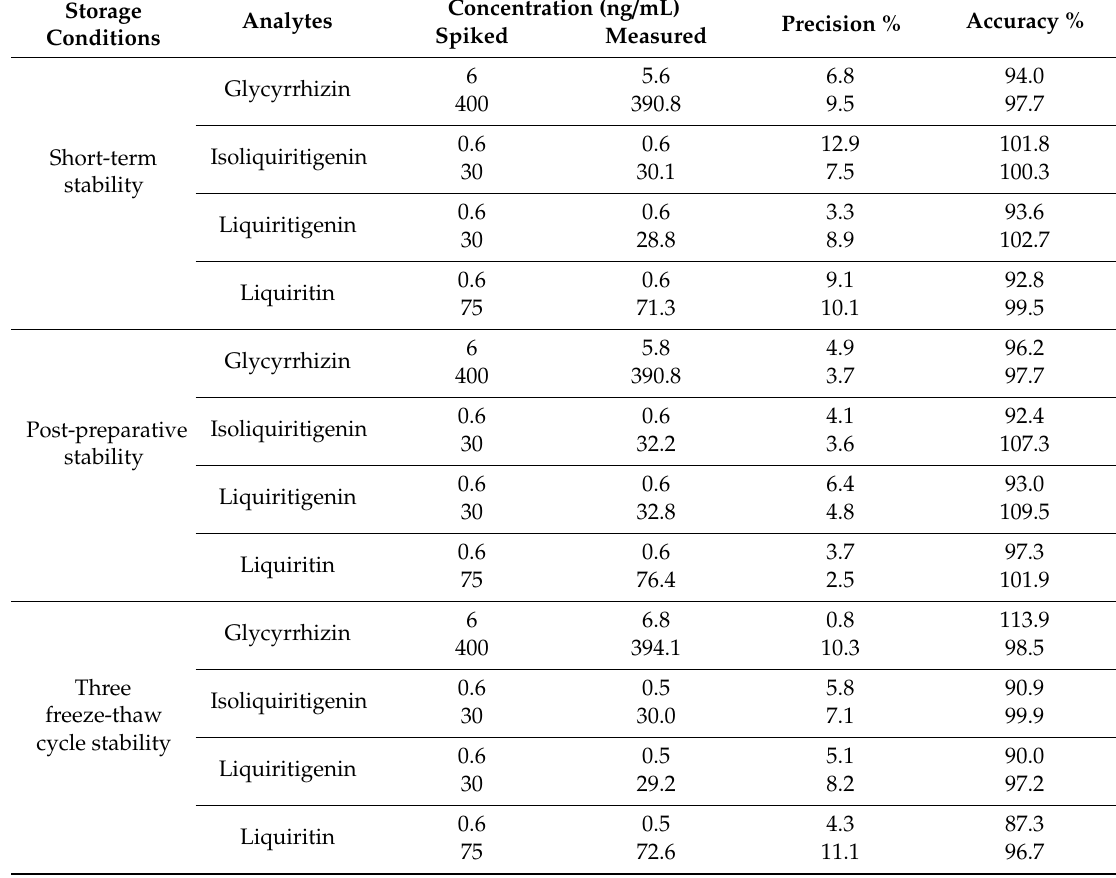
Table 5. Stability of glycyrrhizin, isoliquiritigenin, liquiritin and liquiritigenin.